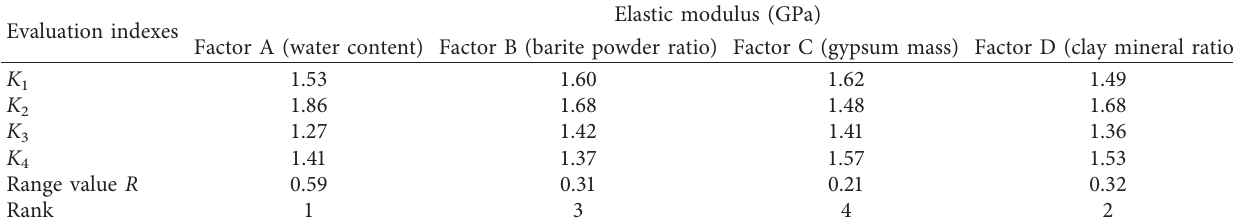
Table 14: Range analysis of elastic